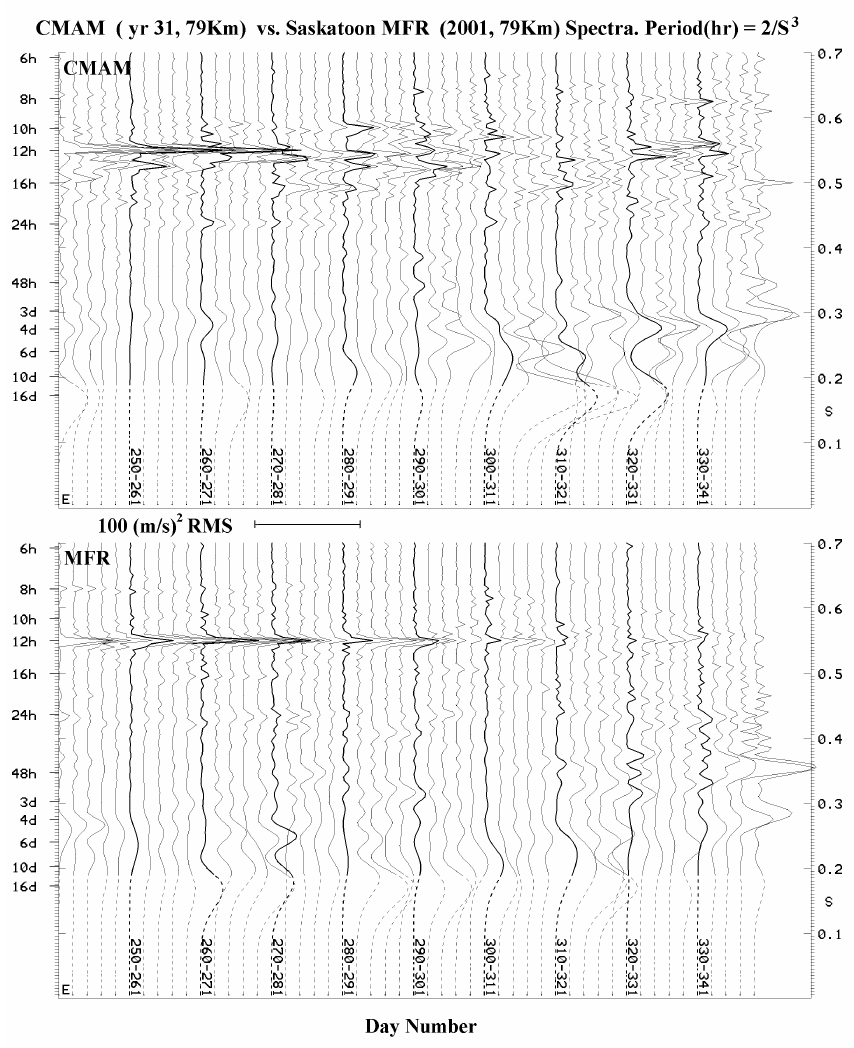
Fig. 3. Spectral analysis of zonal wind data from the MF radar at Saskatoon and from the CMAM model. See Sect. 2.4 for the analysis method and